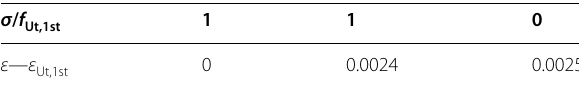
Table 6 Tension plasticity of UHPC‑200.